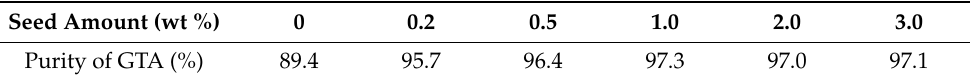
Table 3. Purity of final products under different seed amount (calculated by Equation